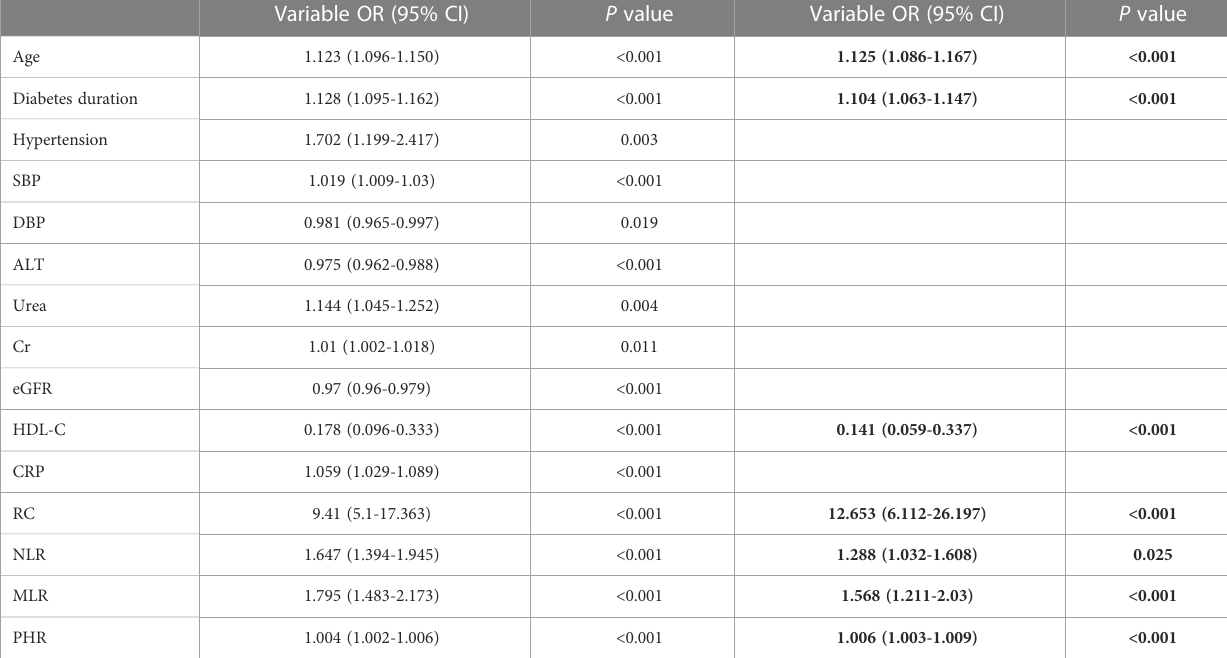
TABLE 4 Univariate and binary logistic regression analysis results.